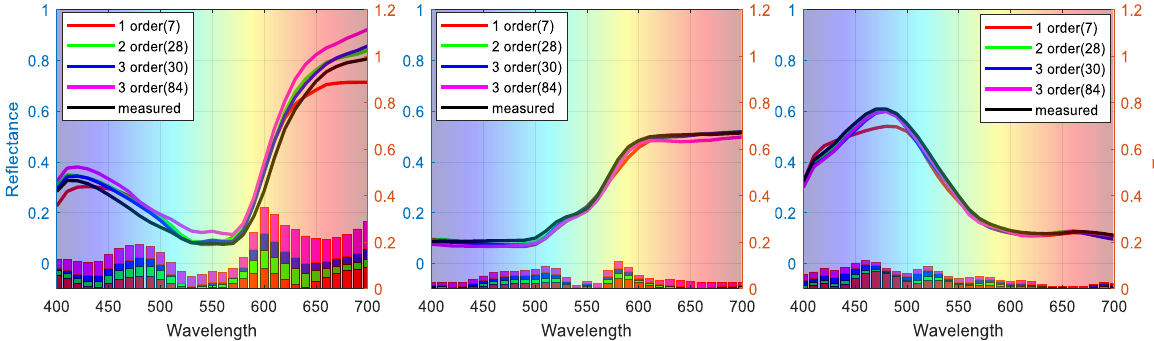
Figure 6. Representative samples of reconstructed spectra with different polynomial expansions.